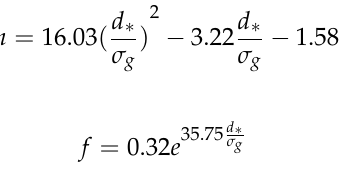
Figure 9. Distribution of f against d ∗ / σ g . The value of f increases with d ∗ / σ g .